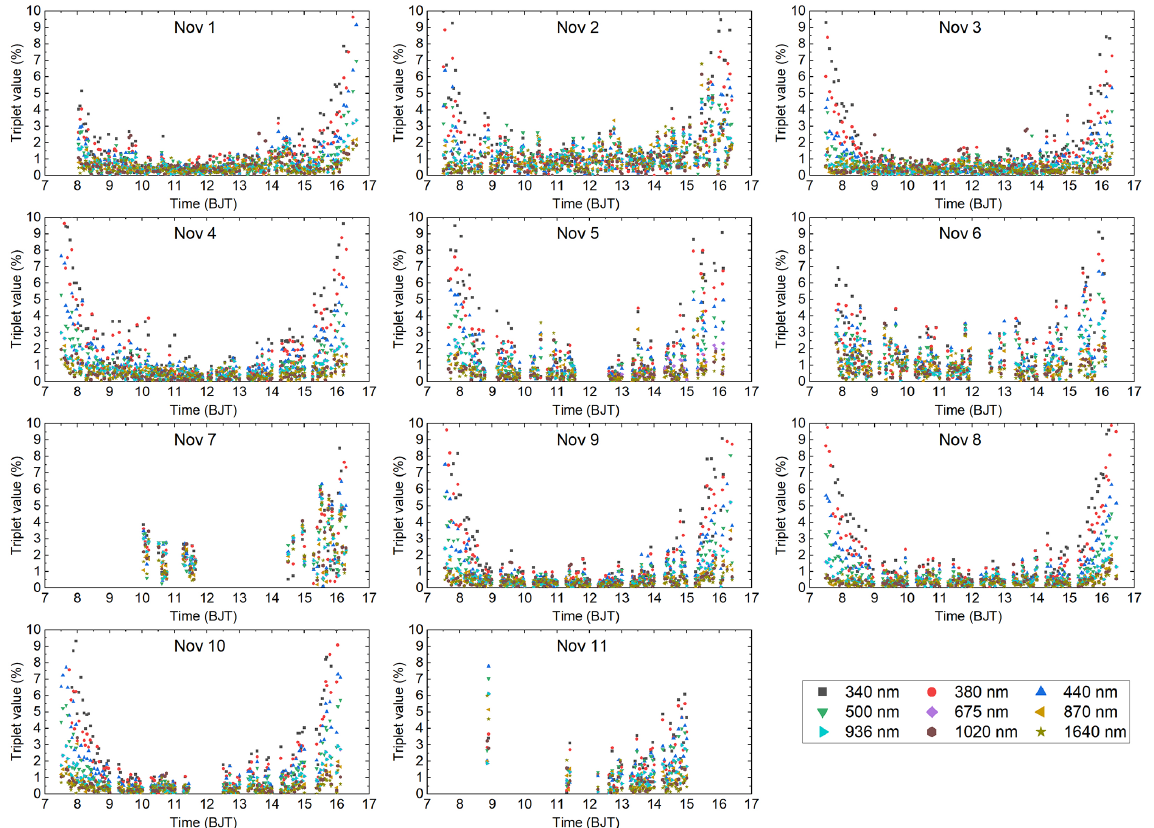
Figure 4. Diurnal variation of the triplet at each wavelength on 11 case